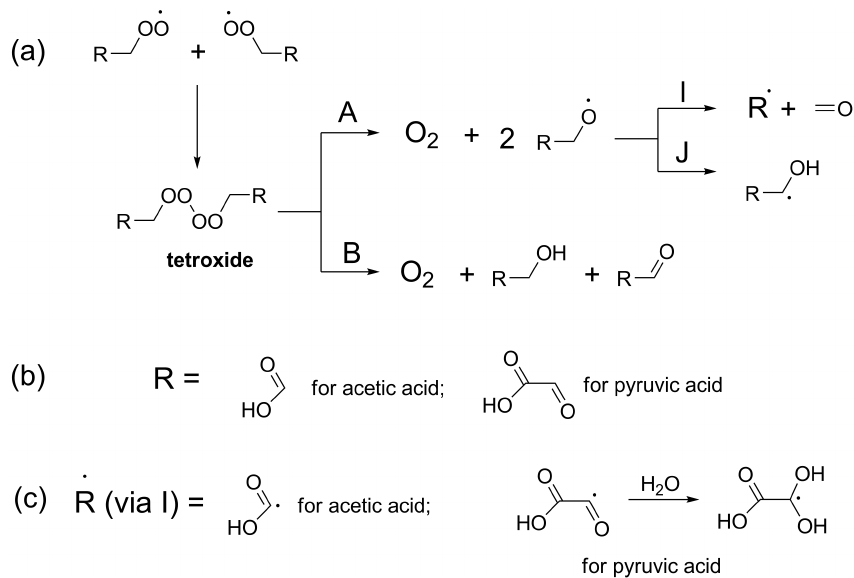
Fig. 1. Mechanism for peroxy radical reactions (a) . The pathway A is suggested by Benson (1965), forming alkoxy radicals, followed by decomposition (I) or 1,2-hydride shift (J). The pathway B forming no organic radical product (i.e., B is a concerted reaction) is suggested by Russell et al. (1957). Parent precursors can be acetic acid or pyruvic acid (b) . Fragmented organic radicals (R*) are expected to be stabilized by a carboxylic group for acetic acid ( (c) left) and a diol, which results from hydration of a carbonyl group for pyruvic acid ( (c)